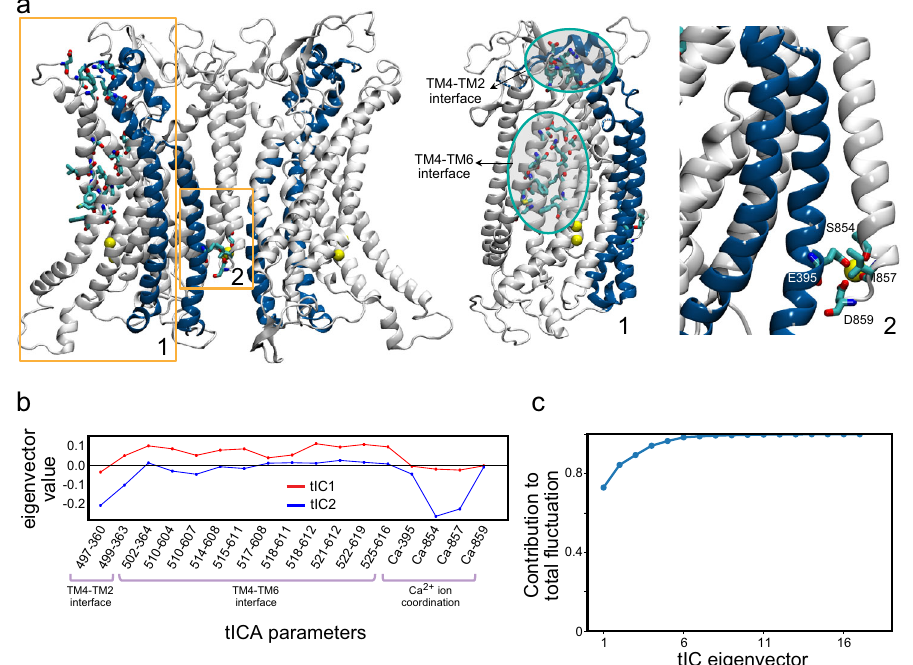
Fig. 2 Description of the CVs used in the tICA dimensionality reduction analysis. a The three regions whose conformational changes are described with the chosen CVs are highlighted on the structure of the mTMEM16F model by the numbered rectangles: 1 . TM4-TM6 and TM4-TM2 interfaces of the groove; 2 . The distal Ca 2 + binding site. In 1 , the speci fi c residues whose pairwise distances throughout the trajectory served as CVs are shown rendered in licorice. In 2 , the four residues coordinating the Ca 2 + ion (yellow sphere) in the binding site are shown rendered in licorice. b Contributions of the CVs used as tICA parameters to the tIC1 and tIC2 vectors. c Contribution of each tIC vector to the total representation of structural dynamics of the